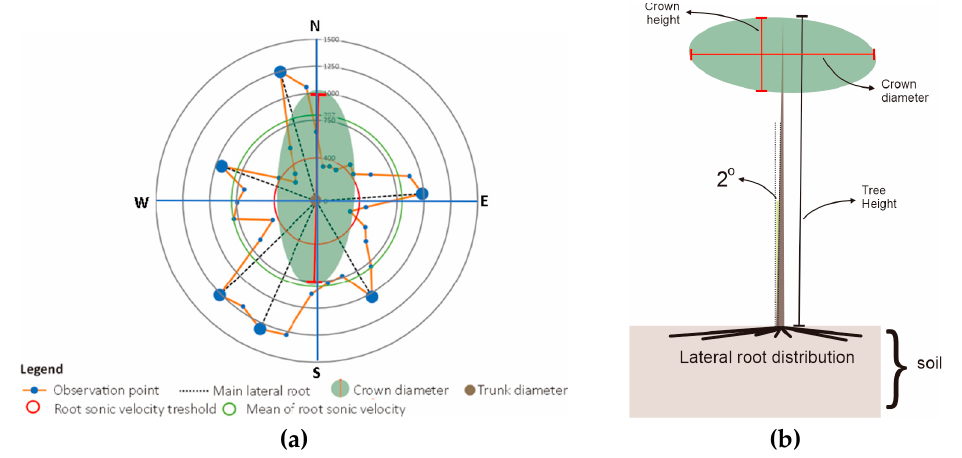
Figure 3 . Representative images of (a) the canopy area (green area) and the distribution of the main lateral roots based on the peak of sonic velocity (dash line), and (b) tree leaning and the crown direction tendency, which were related to the lateral root distribution and the direction of tree growth.